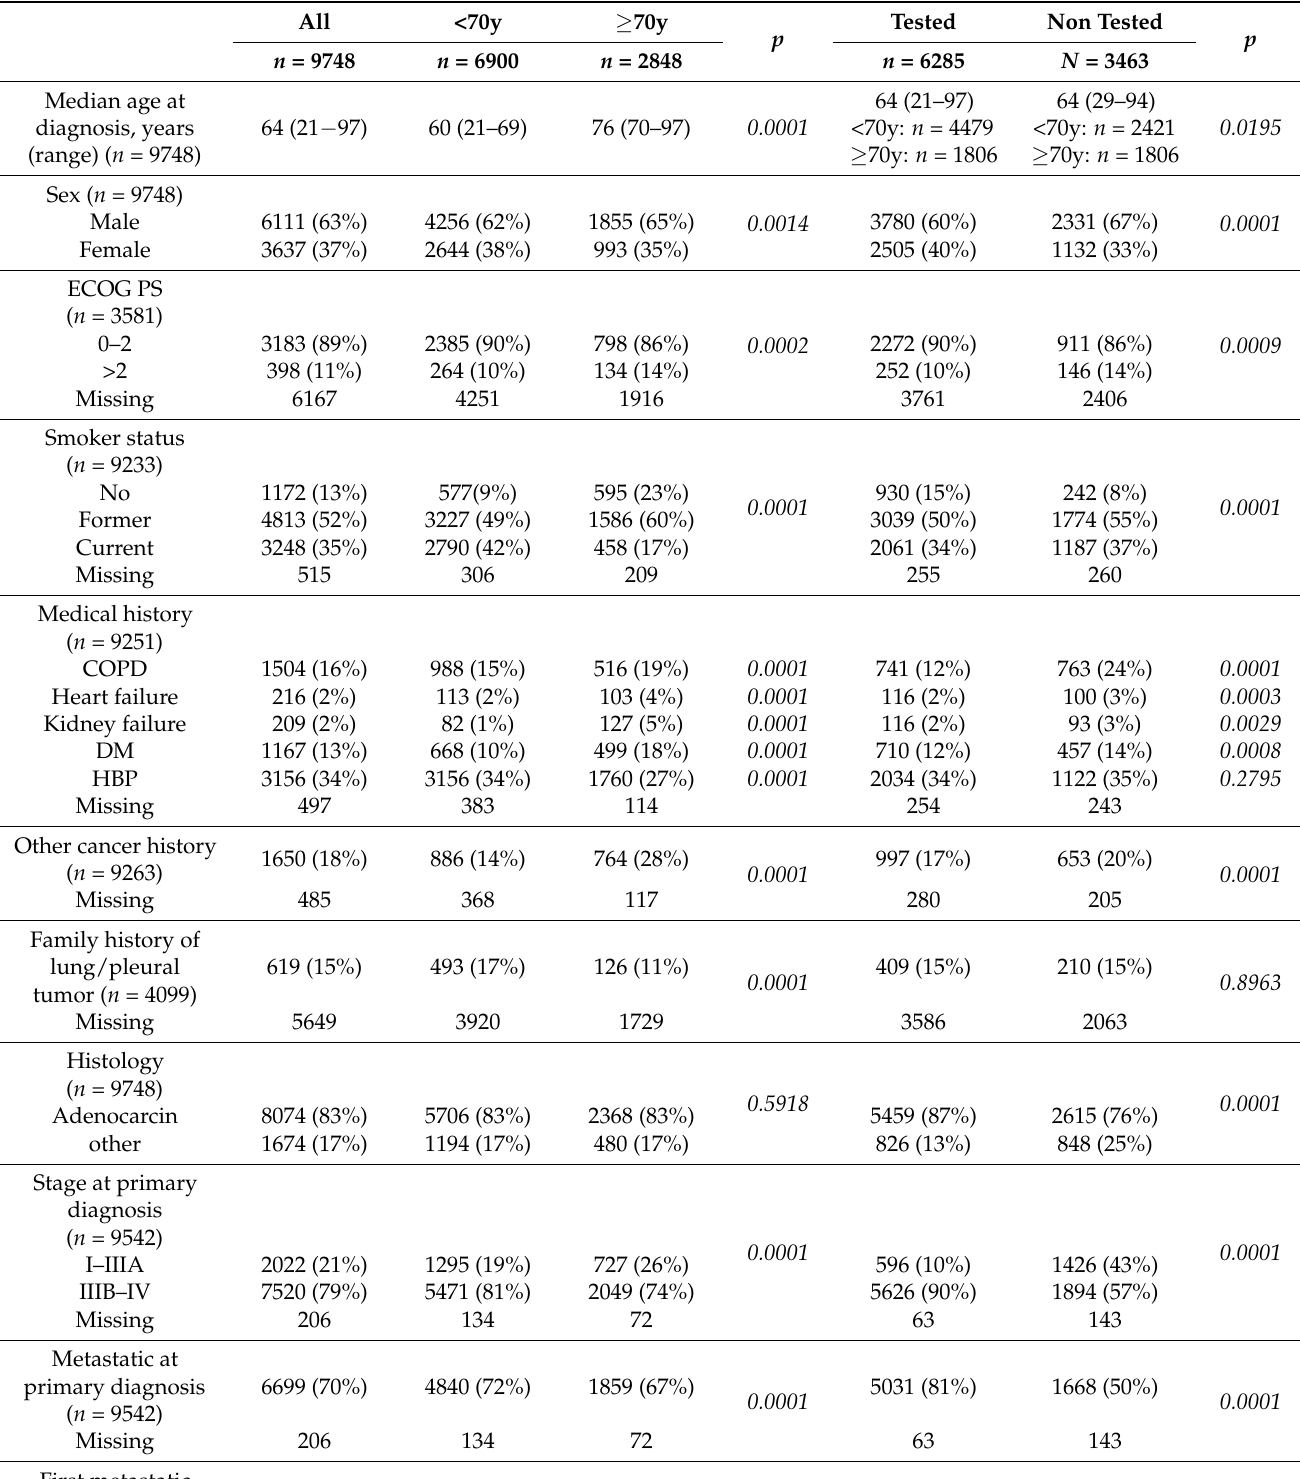
Table 1. Patient